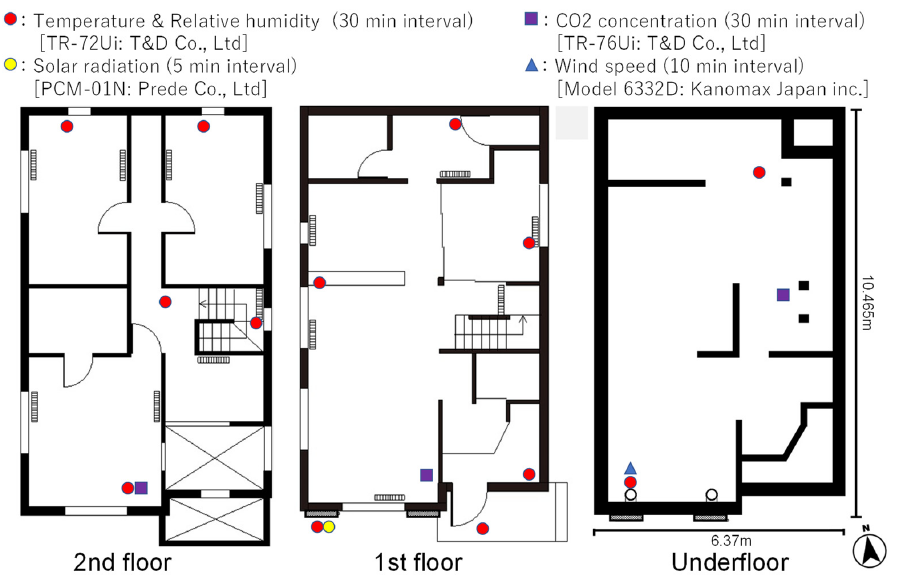
Figure 6. Plan and measurement plan. Table 4. Indoor environment during the measurement period.